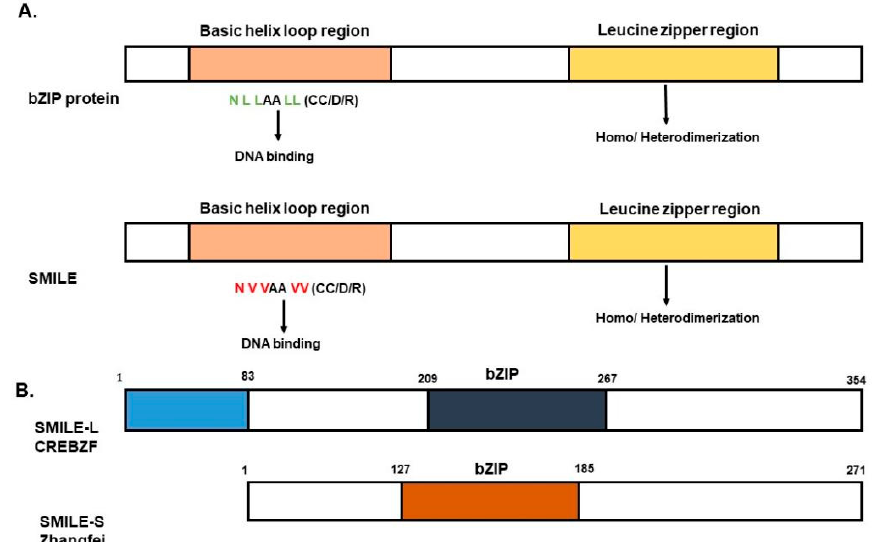
Figure 1. SMILE structure. ( A ). Small heterodimer partner-interacting leucine zipper (SMILE) is a bZIP transcription factor. The sequence of NLLAALL, where L represents leucine, is important in DNA binding. The lack of the N residue and the change of leucine to valine results in a conformational change that is the difference between other bZIP proteins and SMILE, where SMILE lacks the ability to bind to the DNA as a homodimer. ( B ). SMILE has two isoforms, a long form known as SMILE-L/CREBZF and a short isoform known as SMILE-S/Zhangfei (ZF), which are formed by the alternative initiation codon. SMILE-L/CREBZF has the N-terminus region that spans around 83 amino acids, similar to the bZIP CREBH family. The numbers indicate the amino acid number.